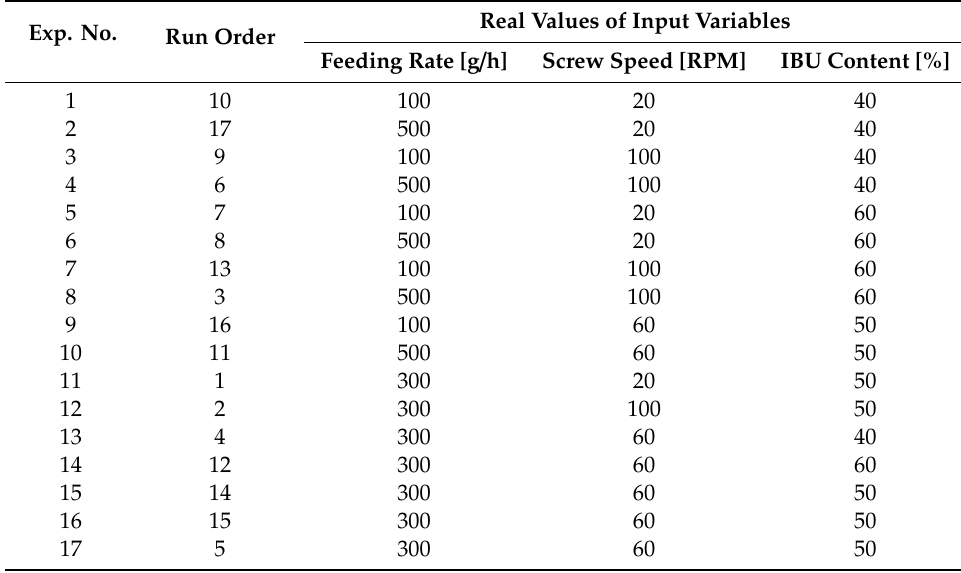
Table 3. Experimental design for the proposed central composite design plan. Real Values of Input Variables Exp. No. Run Order Feeding Rate [g / h] Screw Speed [RPM] IBU Content